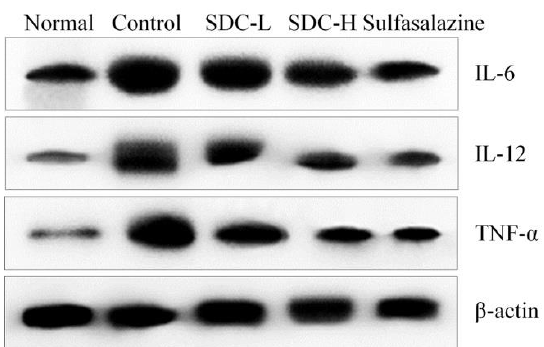
Figure 15. Protein expression levels of IL-6, IL-12, and tumor necrosis factor-α (TNF-α) in the colon tissue of mice. SDC-L: 2 g/kg Shuidouchi extract treatment; SDC-H: 4 g/kg Shuidouchi extract treatment; sulfasalazine: 20 mg/kg sulfasalazine treatment.